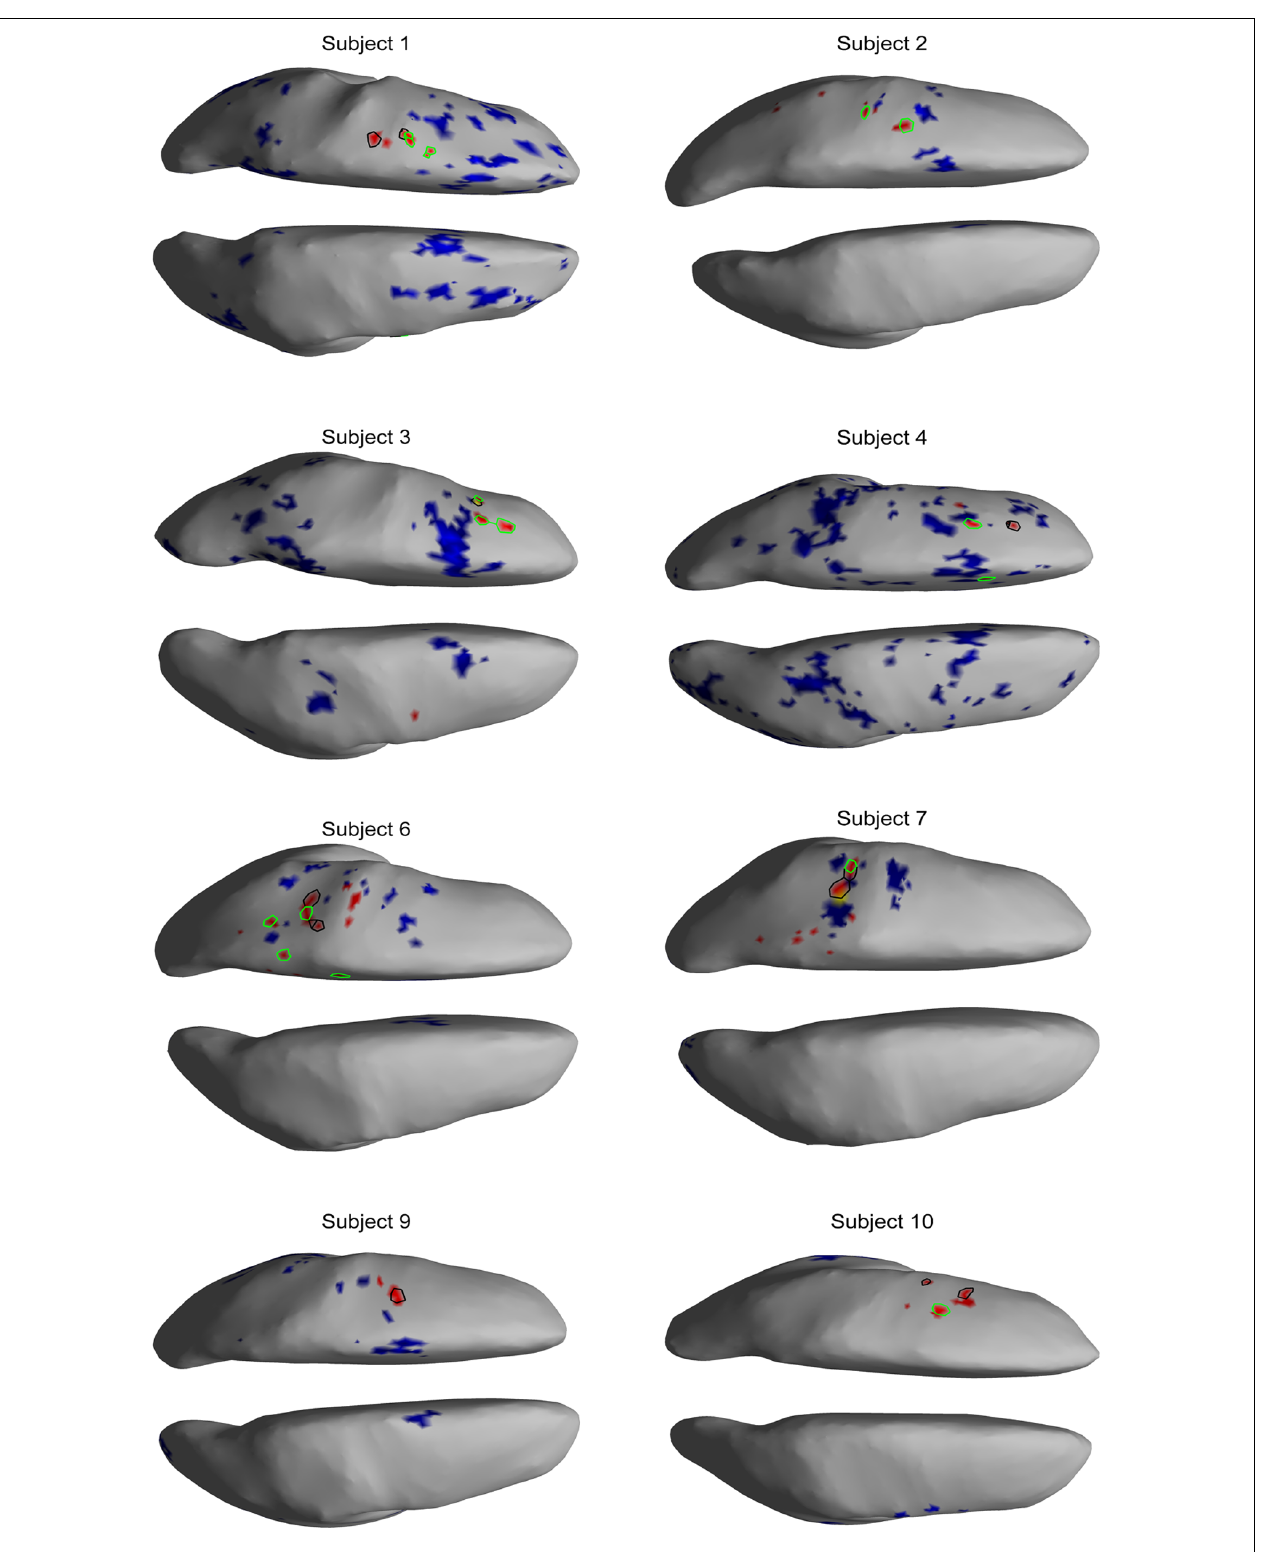
FIGURE 8 | EEG and fMRI BOLD activity mapped to realistic cortical headmodels of the eight remaining subjects during right hand motor imagery.